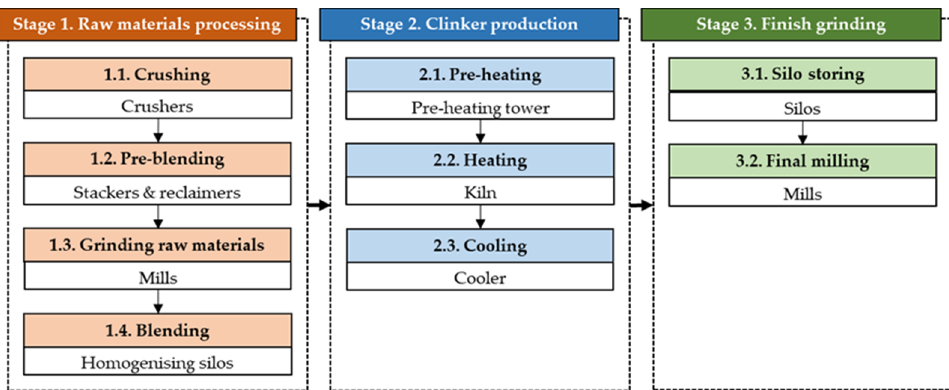
Figure 10. Complete grey-cement production cycle [3].